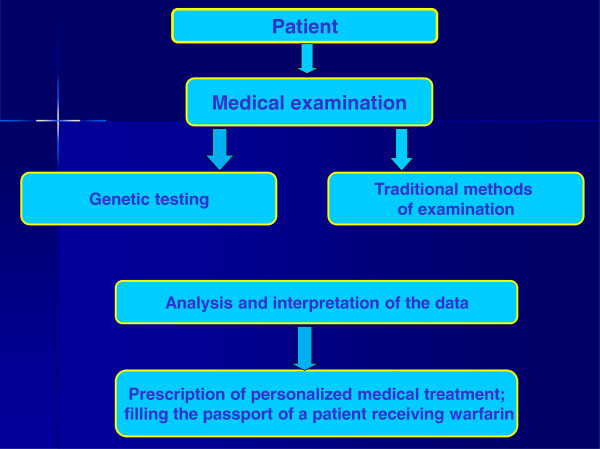
Algorithm to work withthe challenging group ofpatients.